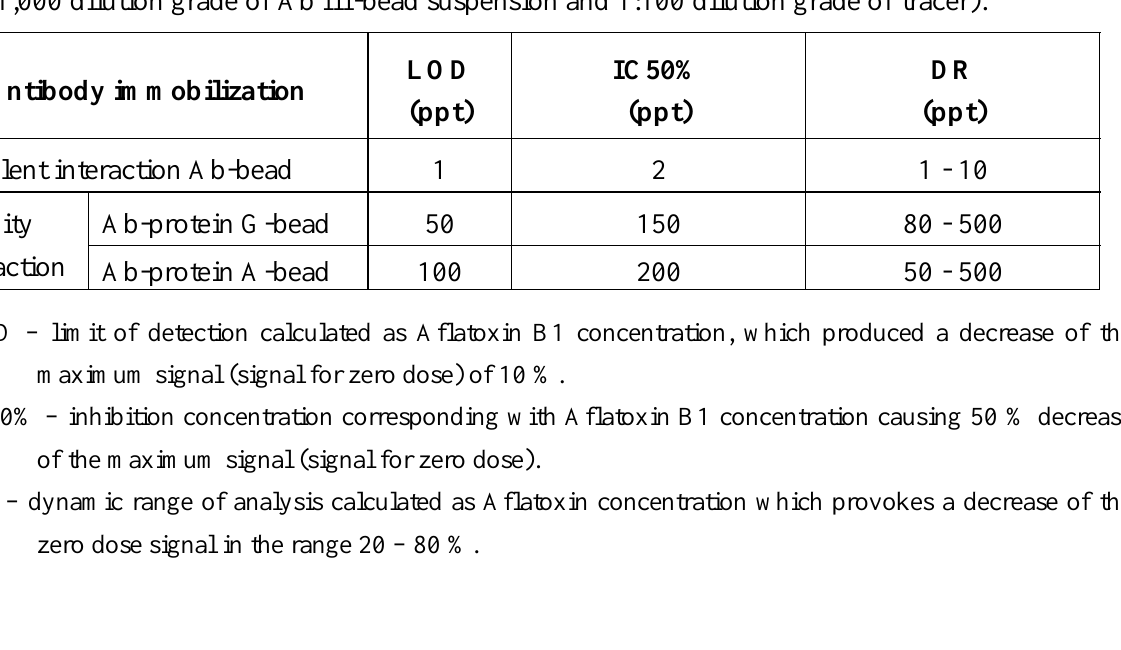
Table 1. Influence of antibody immobilization procedure on the mp -ELISA